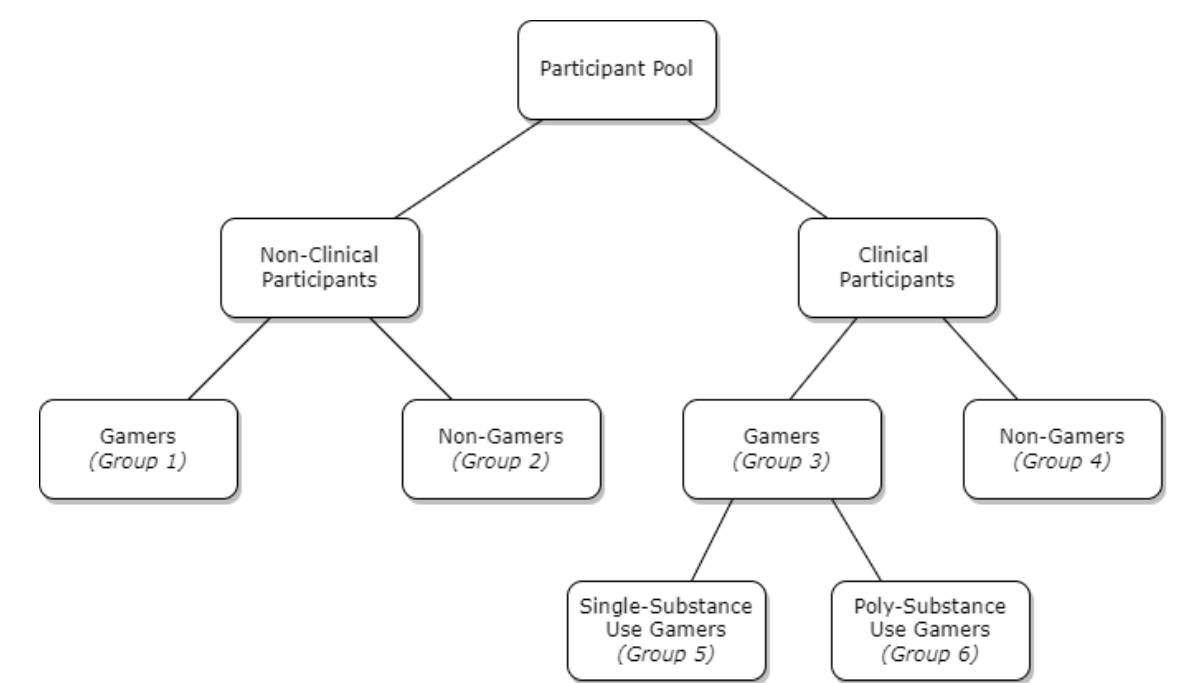
Figure 1. Participant groups: (1) gamers, (2) non-gamers, (3) clinical gamers, (4) clinical non-gamers, (5) single-substance use gamers, and (6) poly-substance use gamers.